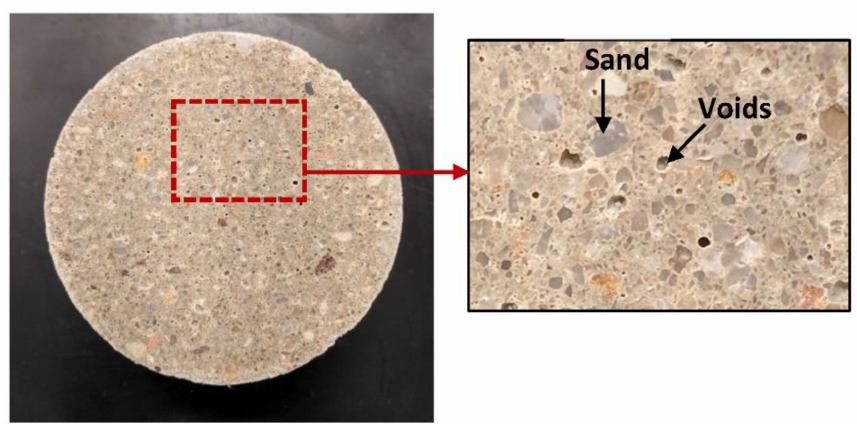
Figure 13. Cross-section of the C-S mix cylinder specimen.